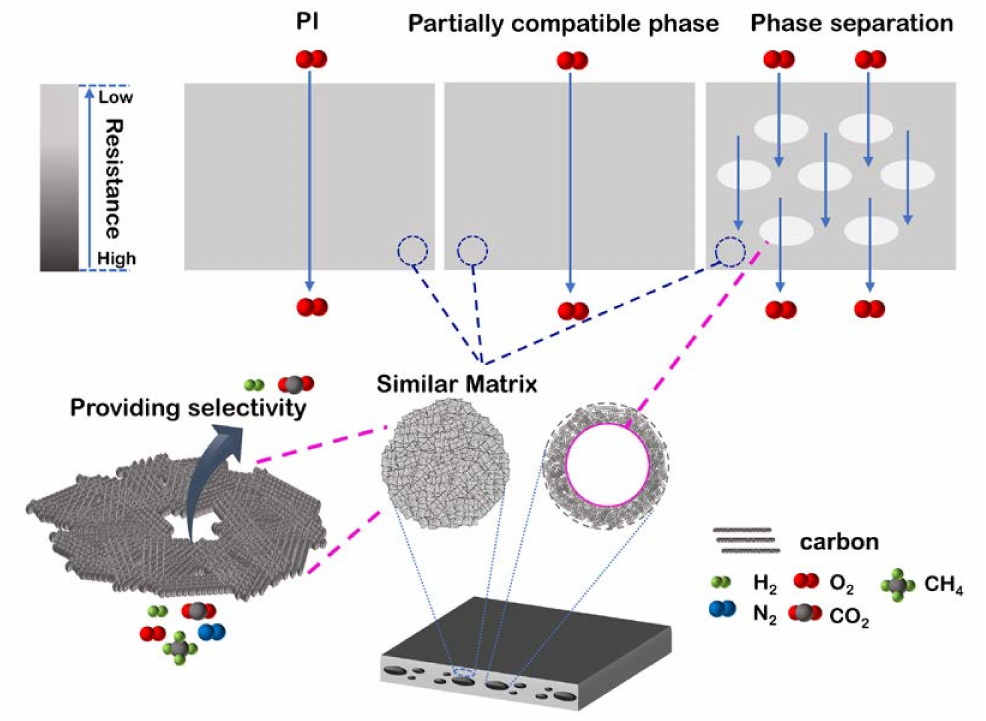
Figure 13. The mechanism of gas permeability of different phase structures for